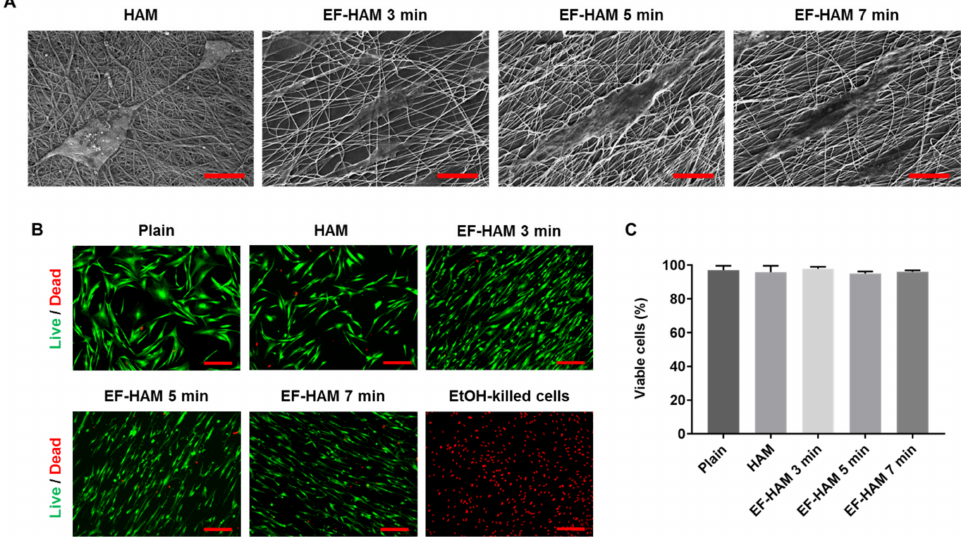
Figure 2. In vitro biocompatibility of HAM and EF-HAM scaffolds with skeletal muscle cells (SkM). ( A ) Electron micrographs showing good adhesion of SkM on HAM and EF-HAM scaffolds. ( B ) Live and dead assay images of SkM stained with Calcein AM and EthD-1 and ( C ) the percentage of viable cells attached to the scaffolds. The values are represented as mean ± SEM (One-way ANOVA). Scale bar: 40 µ m, except for HAM (2 µ m) (in Figure 2A); 200 µ m (in Figure